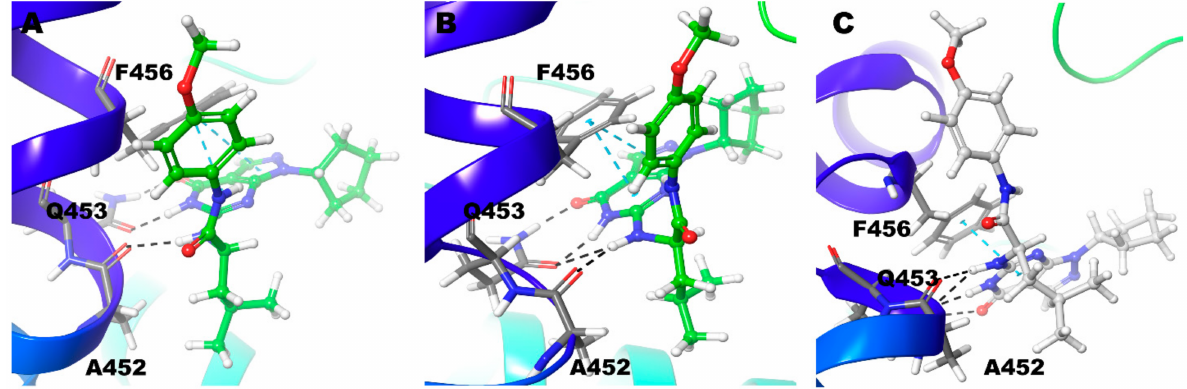
Figure 11. Non-bonded interactions of Compound 6 in ( A ) PDE9 Zn/Mg ( B ) PDE9 Mg/Mg ( C ) PDE9 Zn/Zn.